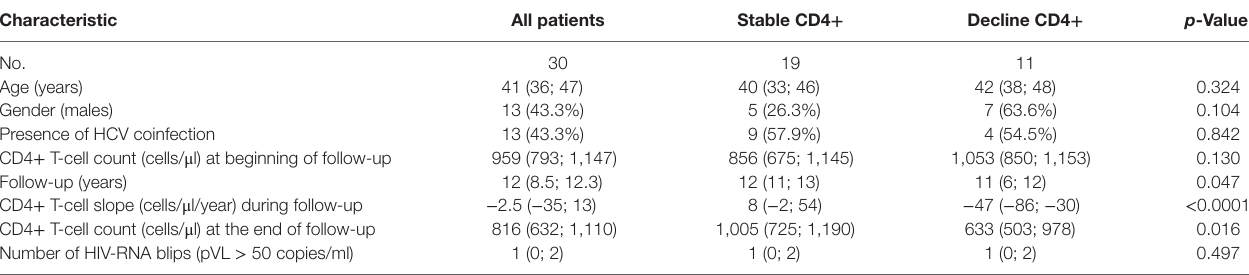
Table 1 | Characteristics of HIV-infected patients included in the study. characteristic